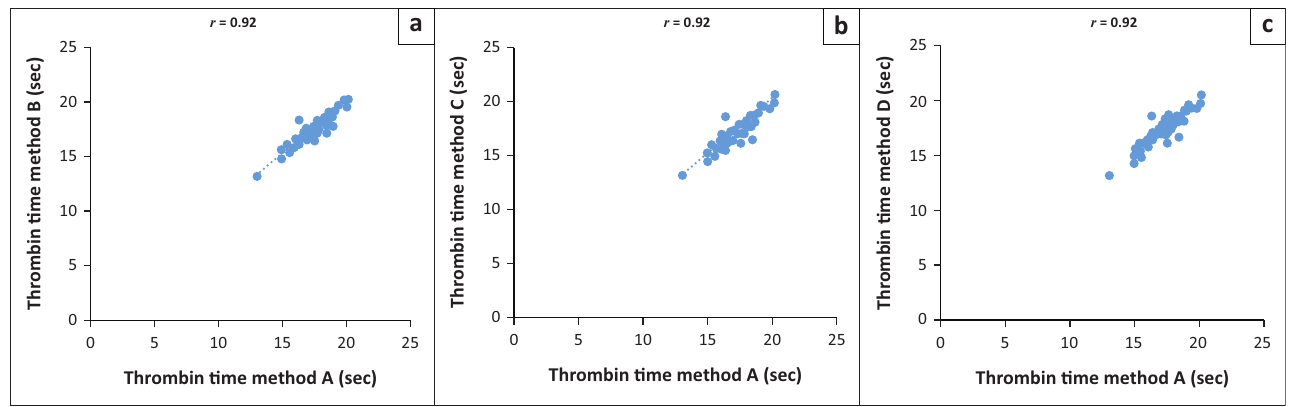
FIGURE 1: Comparison of prothrombin time results between the reference centrifugation method (Method A) and Methods B, C and D, Inkosi Albert Luthuli Central Hospital and King Edward VIII Hospital, Durban, KwaZulu-Natal, South Africa, September 2021 – November 2021. Linear regressions for: (a) Method A vs Method B, (b) Method A vs Method C, (c) Method A vs Method D.